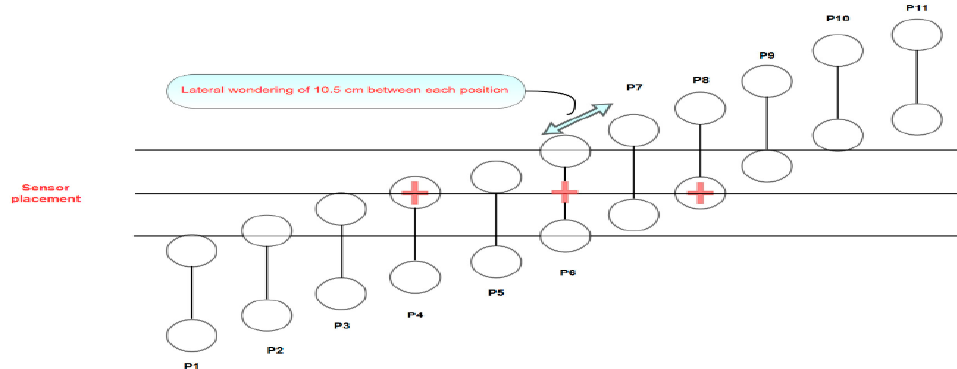
Figure 15. Different wheel positions with respect to the sensors. Figure 15. Di ff erent wheel positions with respect to the sensors.